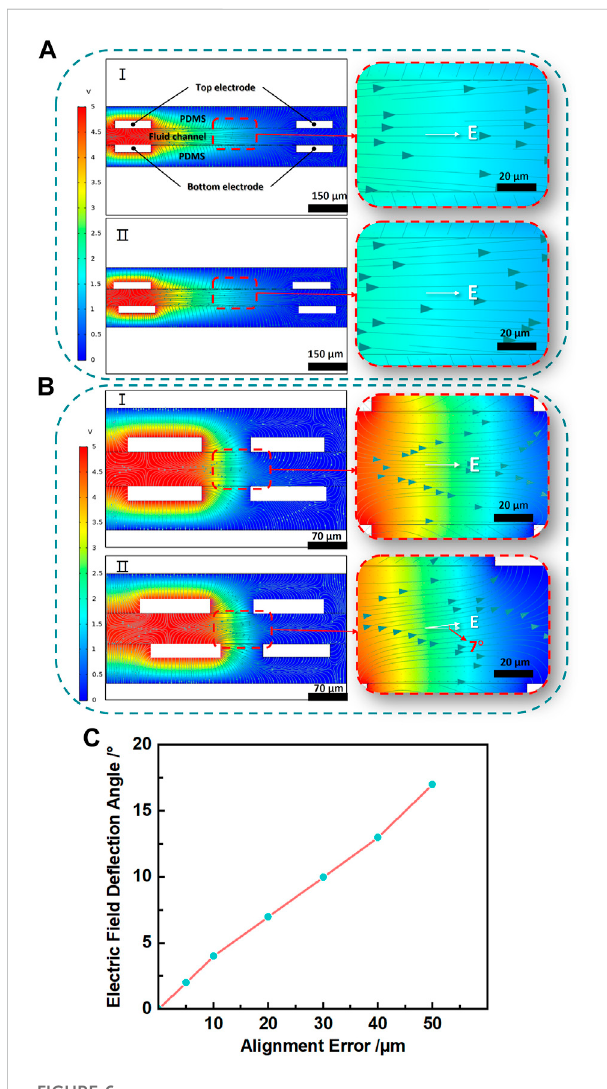
FIGURE 6 (A) I. Electric potential and electric fi eld simulation when the top and bottom electrodes are completely aligned with wide electrode spacing. II. Simulation when the top and bottom electrodes with misalignment and wide electrode spacing. (B) I. Simulation when the top and bottom electrodes are completely aligned with narrow electrode spacing. II. Simulation when the top and bottom electrodes with misalignment and narrow electrode spacing. The right image is the enlarged partial image of the left image, and E is the electric fi eld direction in this area. (C) Relationship between alignment error and electric fi eld de fl ection for the smaller